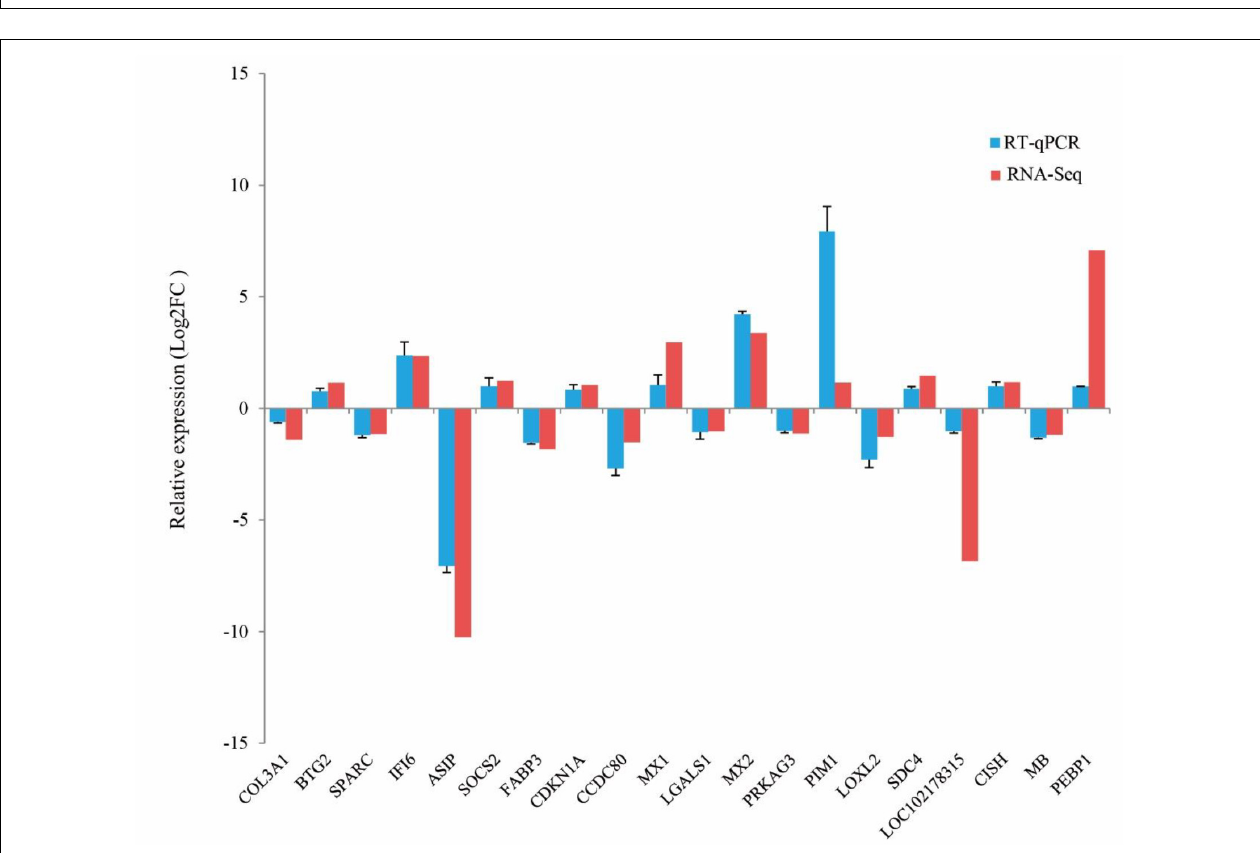
FIGURE 4 | KEGG pathway analysis for the up-regulated genes (A) and down-regulated genes (B) in ZB goats compared to LC goats.